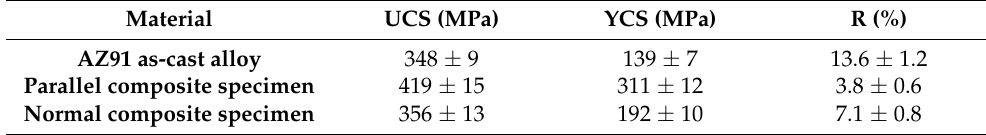
Figure 9. The compressive stress against the reduction in the height for the AZ91 matrix and AZ91/23 vol.% carbon fiber composite specimens. Table 4. Summarizes the ultimate compressive strength (UCS), yield compressive strength (YCS), and reduction in height (R) values for the AZ91 matrix and AZ91/23 vol.% carbon fiber composite specimens.